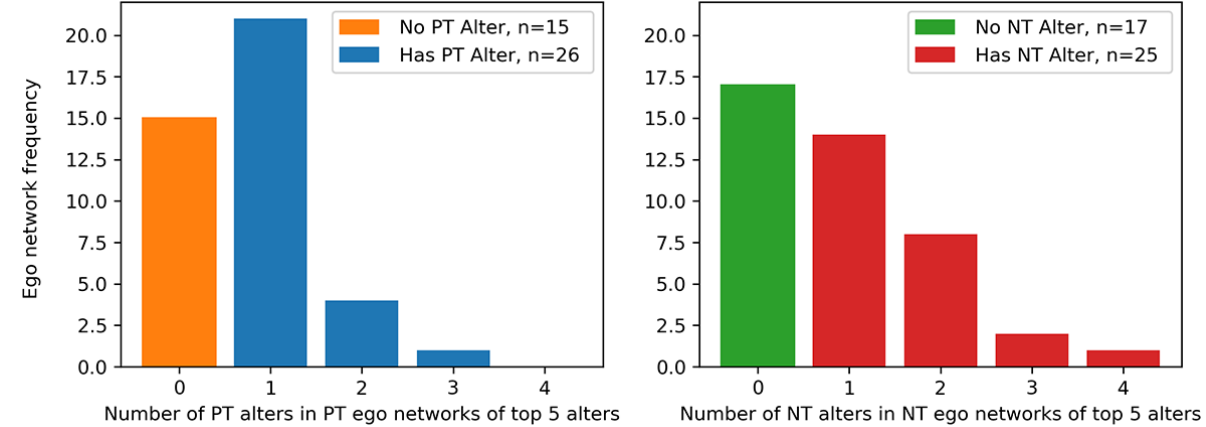
Figure 7. Distribution of same-trend alters in positive trend and negative trend ego networks. NT: negative trend; PT: positive trend.